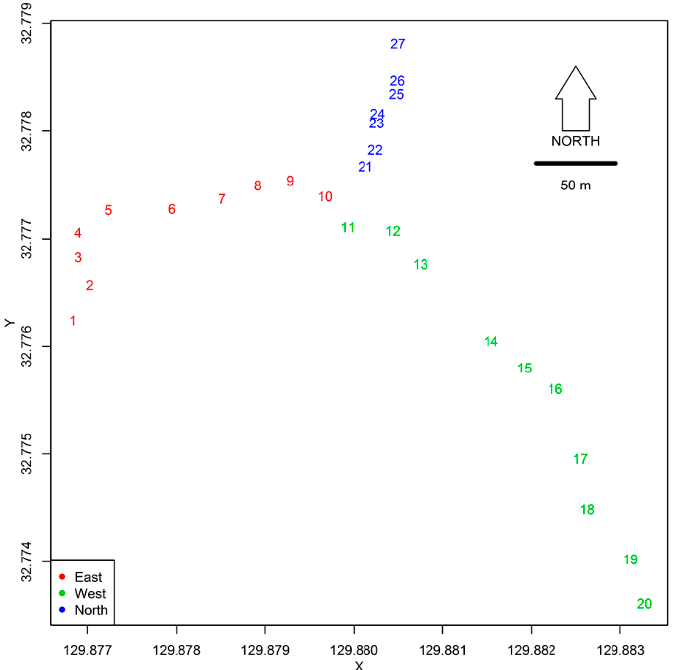
Figure 2. Map highlighting the sampling transects, indicated by color, and the identity code given to each sampling point (focal